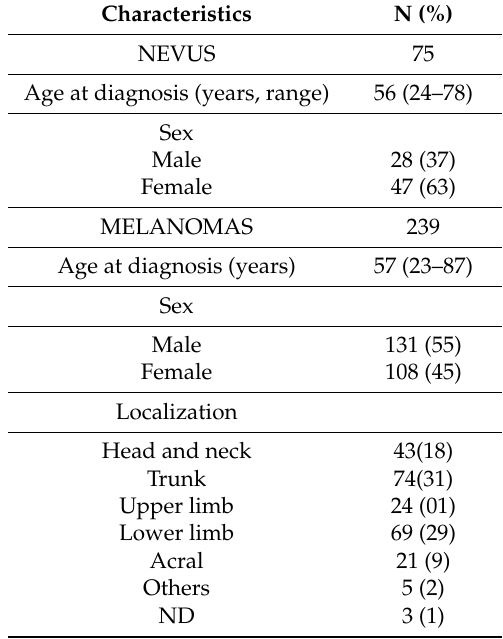
Table 1. Clinical and pathological data from nevus and melanoma